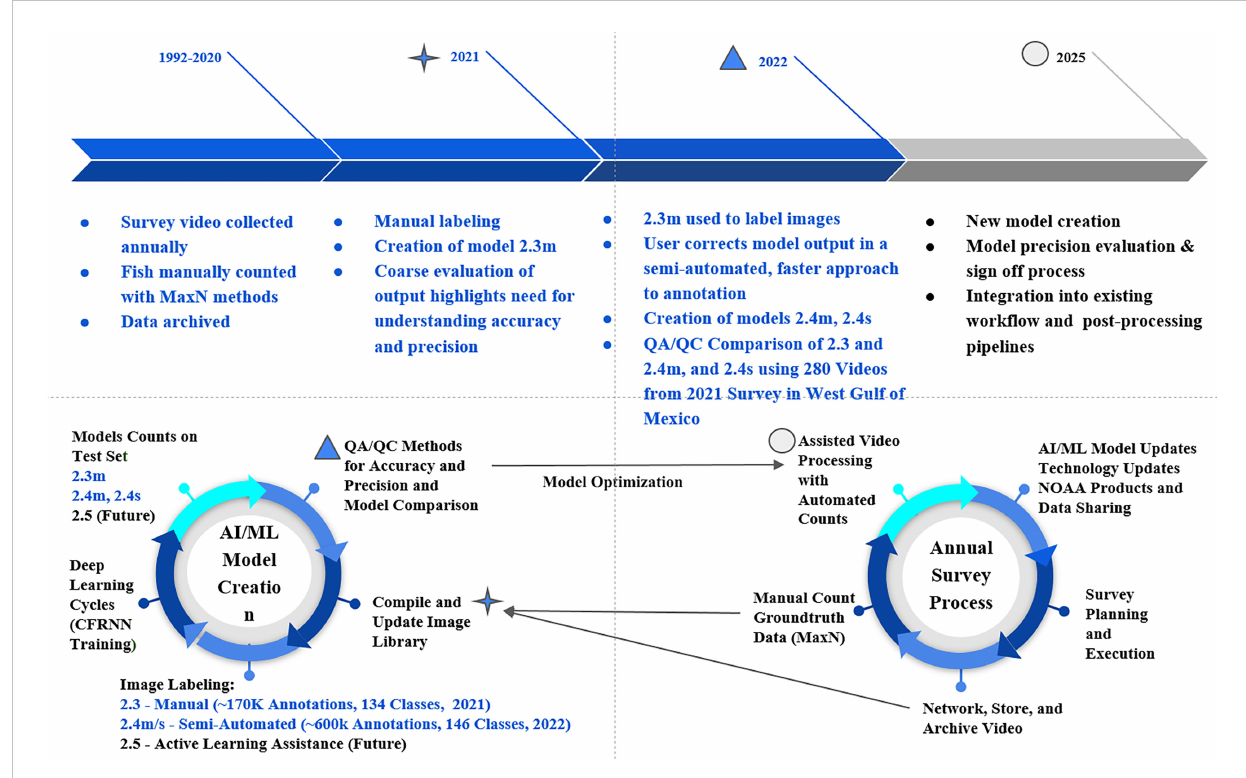
FIGURE 1 Combined work fl ow of model development and the annual survey process. MaxN manual counts are the maximum number of the same species, observed in the same frame, during a 25-minute station video. Model nomenclature “ s ” denotes single-frame fi sh tracking algorithms and “ m ” denotes motion-based tracking. Models 2.4s and 2.4m are available in a GitHub repository (https://github.com/VIAME/VIAME). These models are also available for public use as embedded pipelines on the VIAME web